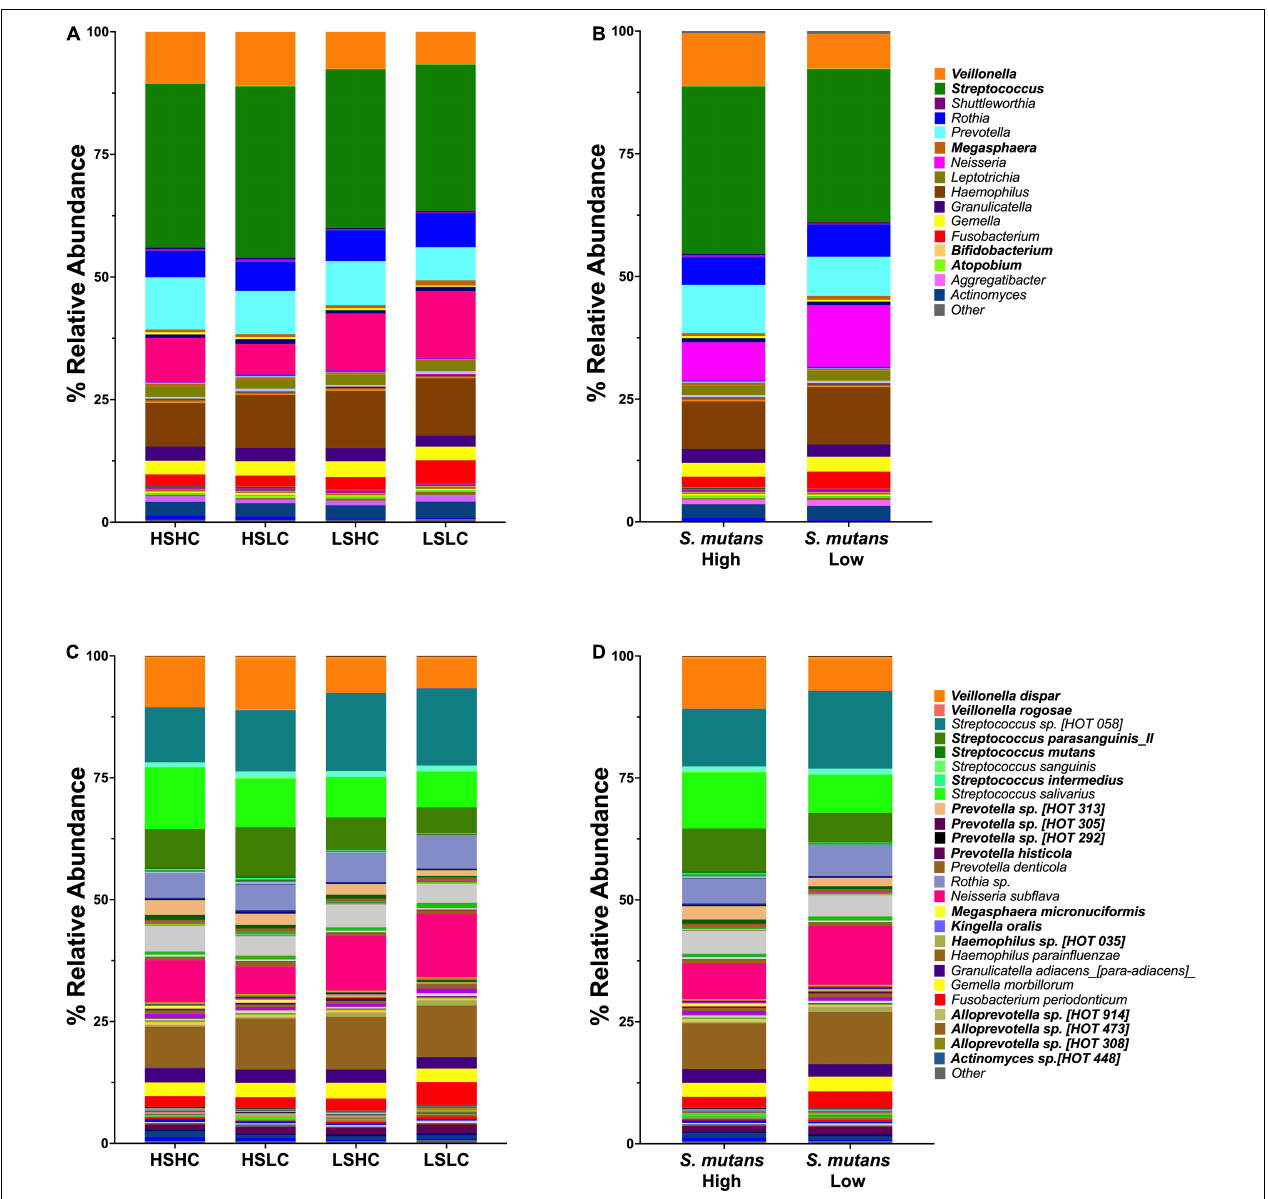
FIGURE 2 | Genus and species level analysis of salivary microbiome community. Relative abundances are shown for salivary microbial profiles at genus (A,B) and species (C,D) level. (A,C) Per group (HSHC, HSLC, LSHC, and LSLC). (B,D) S. mutans levels (High, Low). Statistical significance was evaluated by one-way ANOVA followed by Kruskal–Wallis multiple comparisons